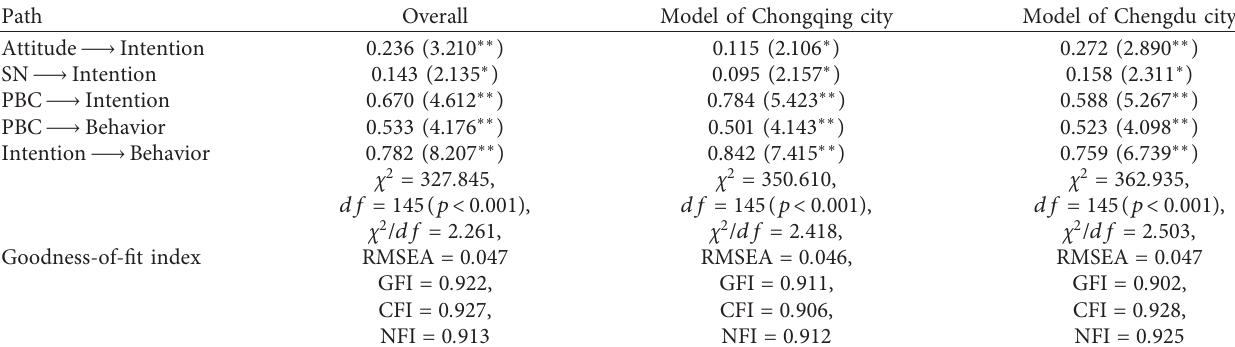
Table 5: Structural parameter estimates and goodness-of-fit